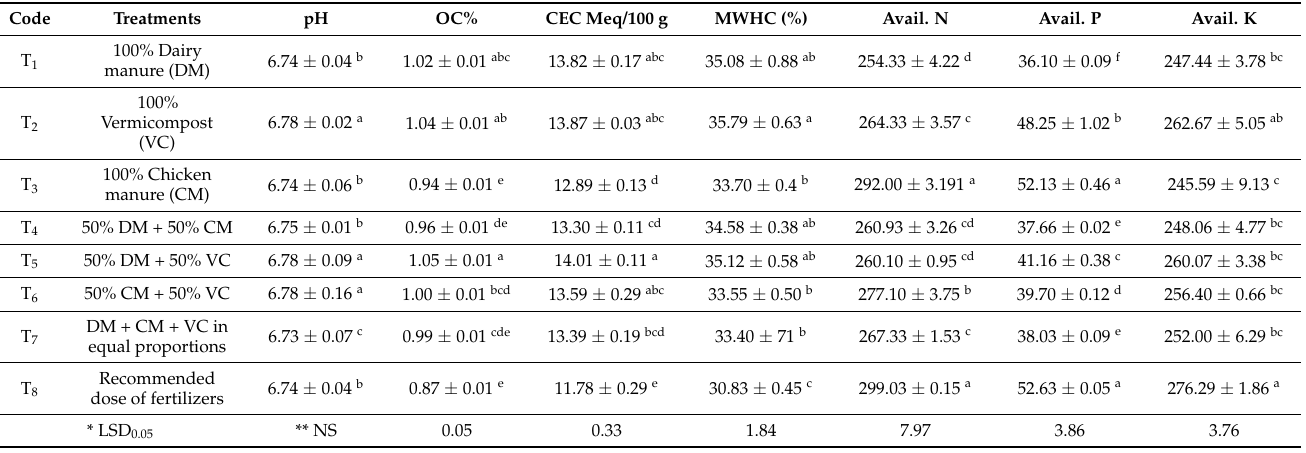
Table 4. Impact of organic manures on physicochemical properties of soil in kiwifruit orchard.